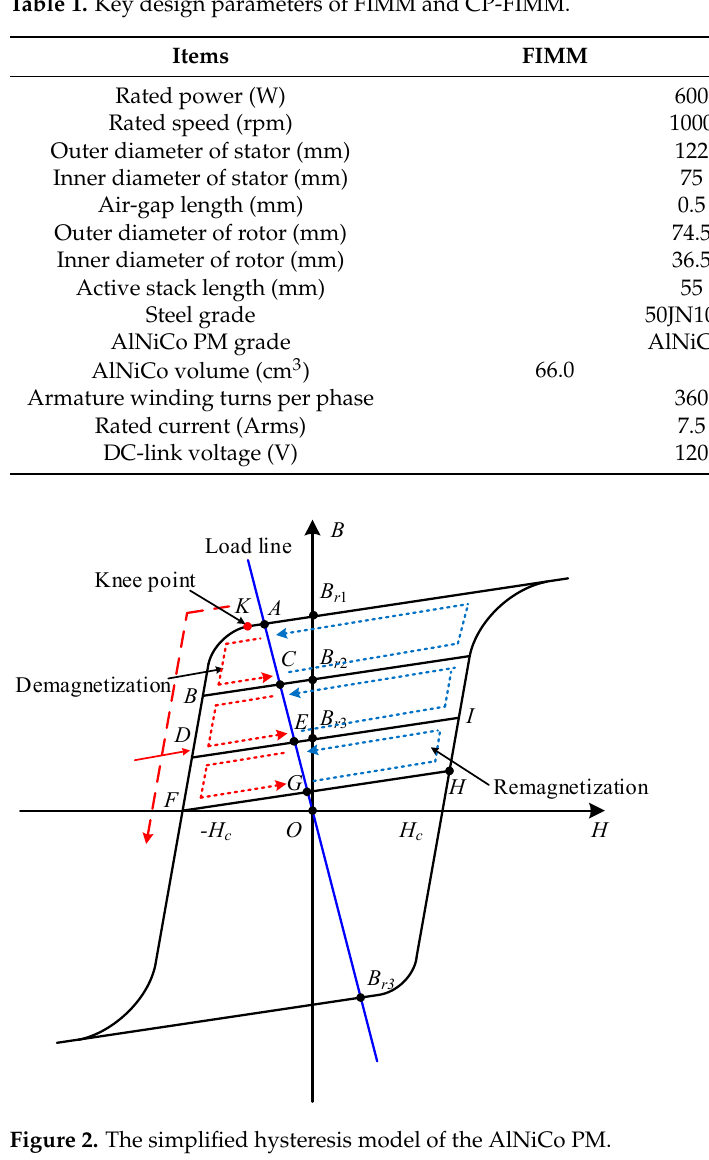
Figure 2. The simplified hysteresis model of the AlNiCo PM.